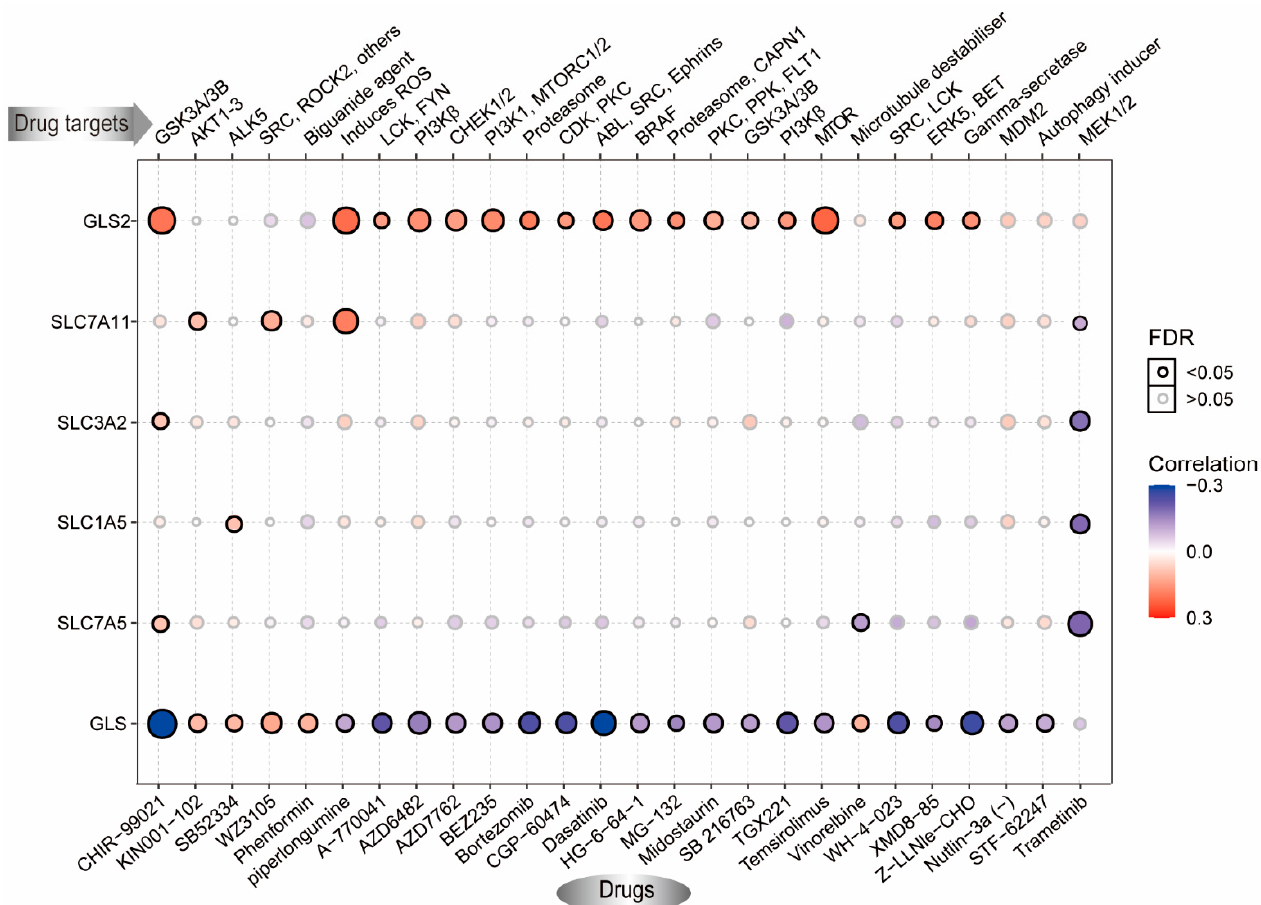
Figure 8. Effects of glutamine metabolism (GLNM) regulator expression on drug sensitivity based on the GDSC database. The horizontal axis represents different drugs, with the paired drug targets displayed above. Blue represents negative correlations and red represents positive correlations. Black circles indicate FDR < 0.05 and gray circles indicate FDR > 0.05.